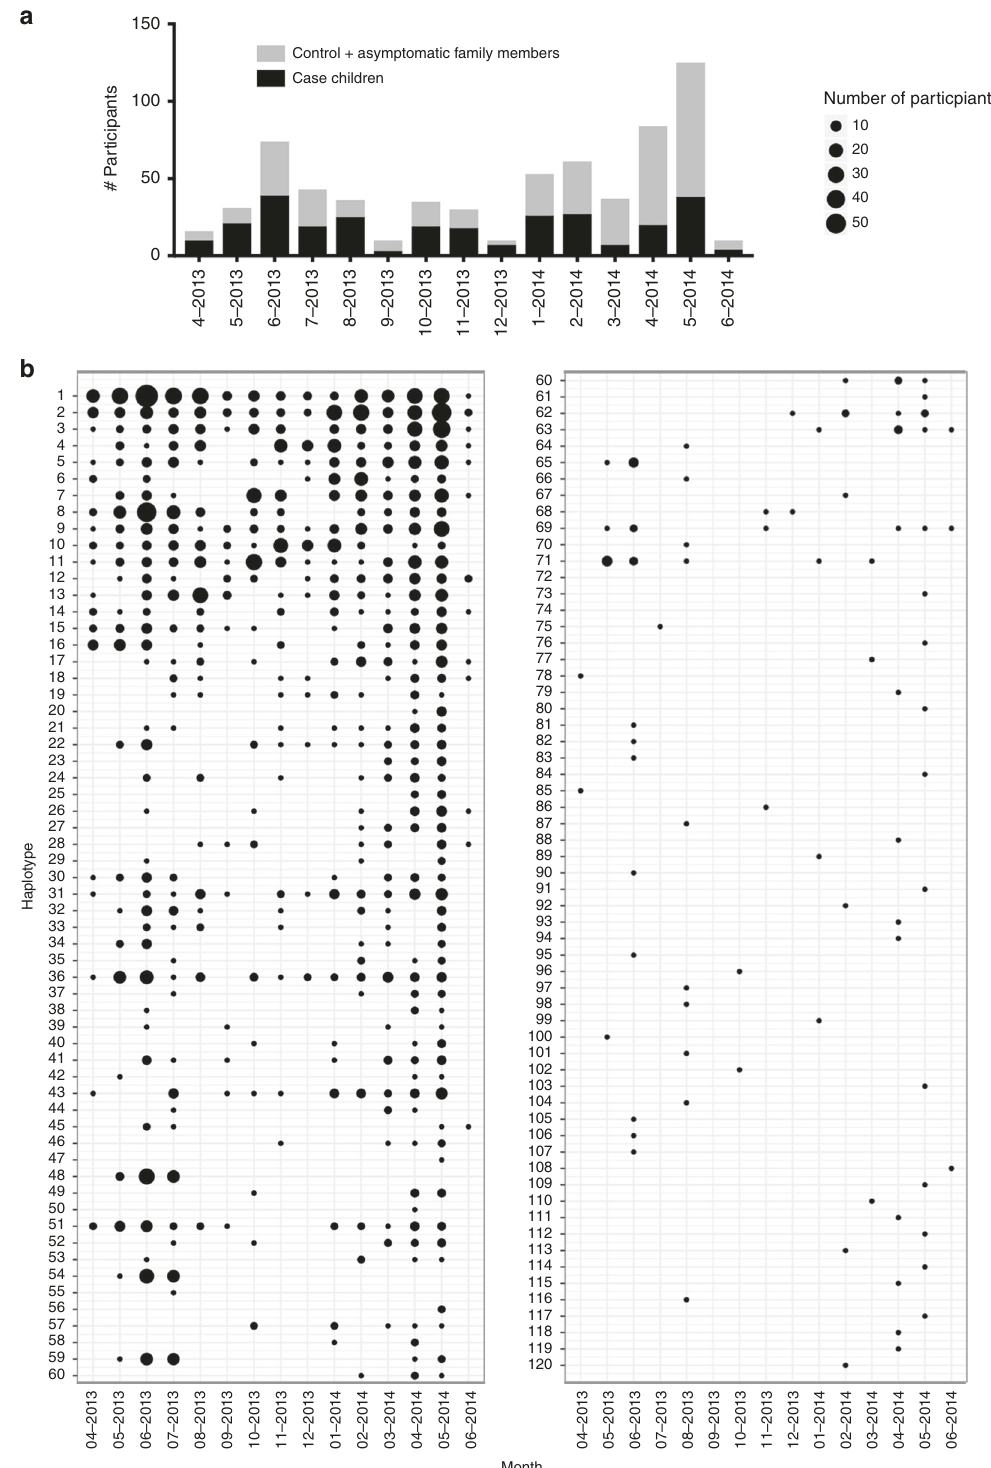
Fig. 2 Heterogeneous persistence of csp haplotypes over time. a Total number of study participants with csp haplotypes by month. Black denotes case children, and gray indicates both control and case household members. b Monthly prevalence of 120 unique csp haplotypes, sorted by overall prevalence. Size of circle indicates number of study participants with a particular haplotype in a given